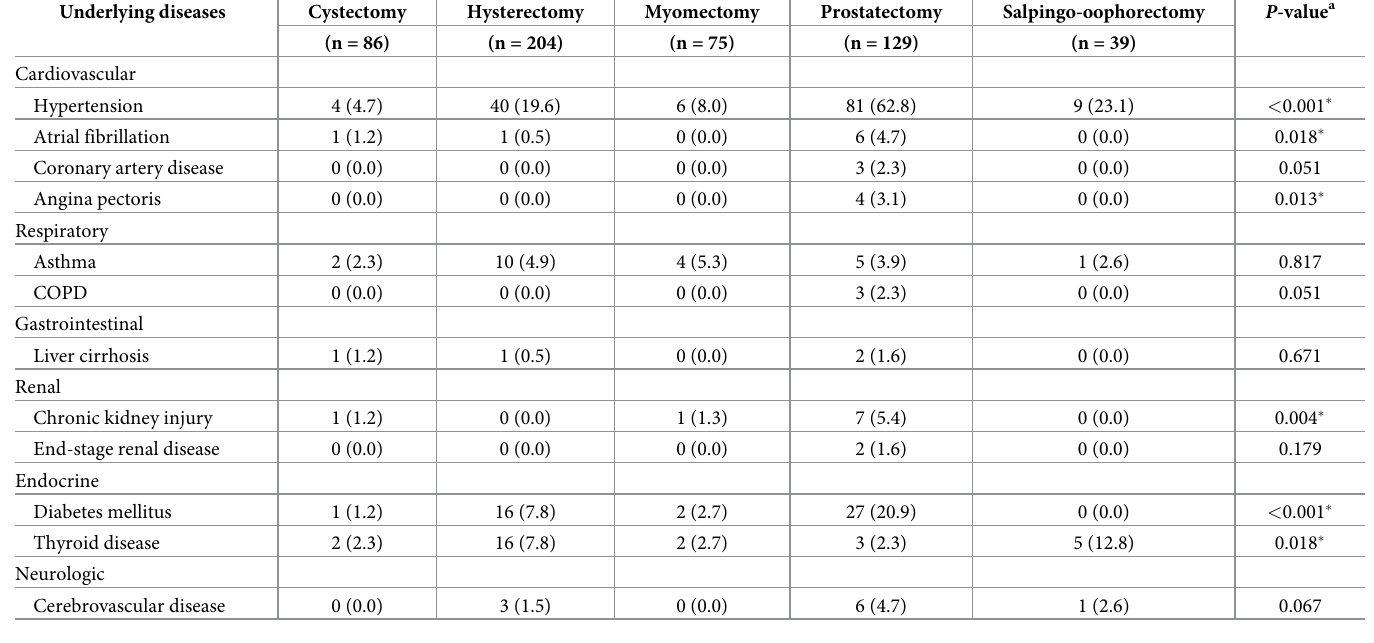
Table 3. Underlying comorbidities of patients based on surgery